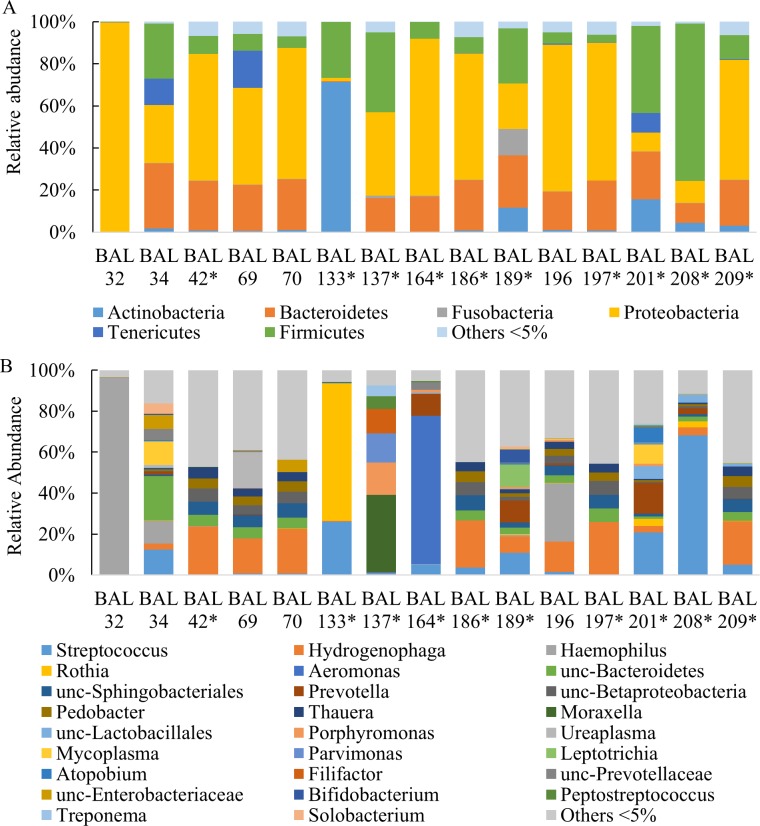
Relative Abundance of Culture Negative BAL Samples.Raw BAL from culture negative BAL samples were sequenced on the Ion Torrent PGM by amplifying the v4 region of the 16S rRNA gene. Analysis of the sequences were completed with the mothur pipeline using the RDP reference database. The number of sequences of bacteria were converted to percentages of the total. Only taxon comprising >5% of a sample were graphed; anything <5% is listed as other. Phylum (A) and genus (B) level taxonomy are presented. Unc-denotes that the sequence was unclassified at the genus level, and the lowest level identified is listed instead. *Screening BALs.